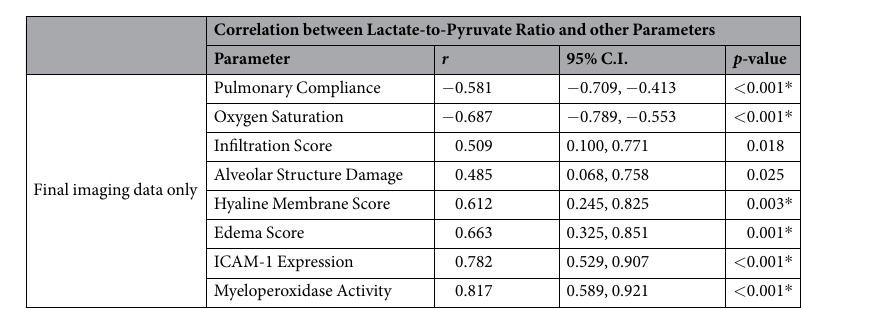
Table 3. Pearson correlation coefficients between the global lactate-to-pyruvate ratio and other experimental parameters. Pulmonary compliance and oxygen saturation was measured at the beginning of carbon-13 imaging. Histological features were only correlated with the last imaging time-point. Bonferroni correction was applied for 8 univariate correlation tests (significance for adjusted α adj. = 0.05/8 =